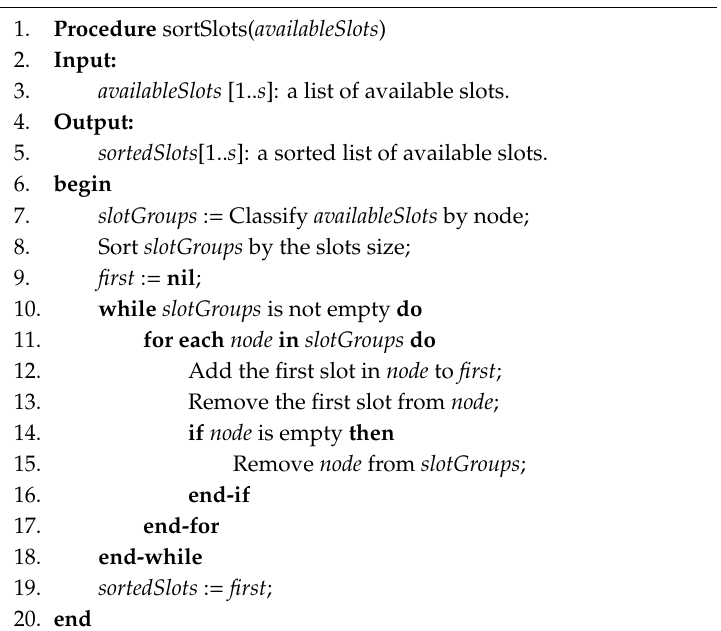
Algorithm 1 Process slots sorting algorithm for the fairness